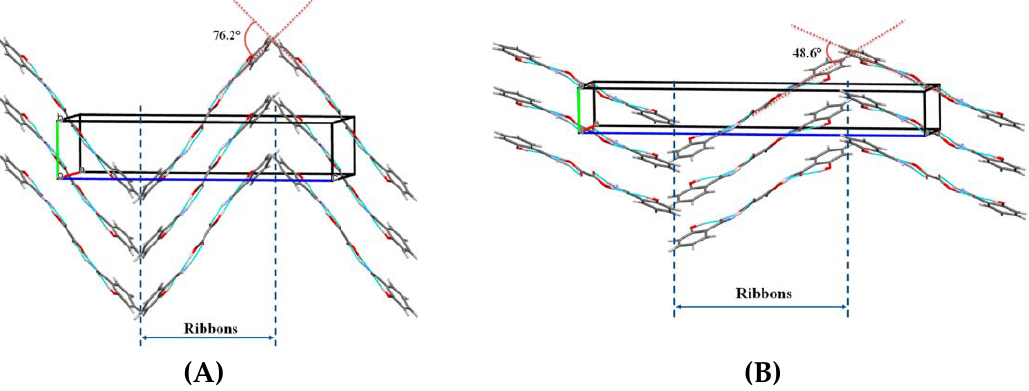
Figure 30. Molecular packing projections of salicylamide-oxalic acid (2:1) ( A ) form I and ( B ) form II cocrystal along crystallographic an axis [Reprinted from [307] with permission. Copyright 2017 American Chemical Society].